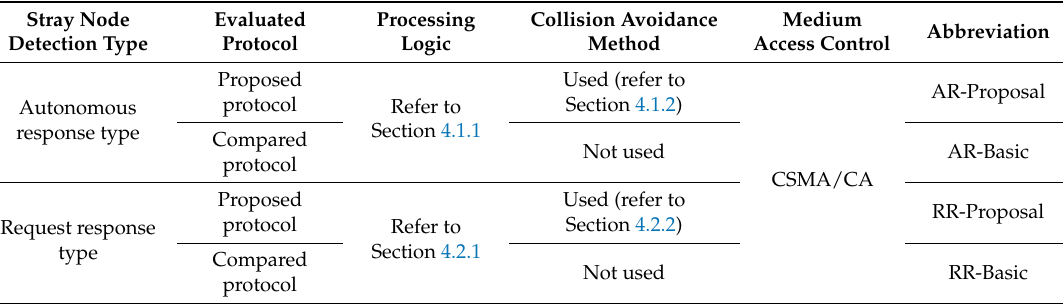
Table 3. Stray node detection protocols evaluated and their